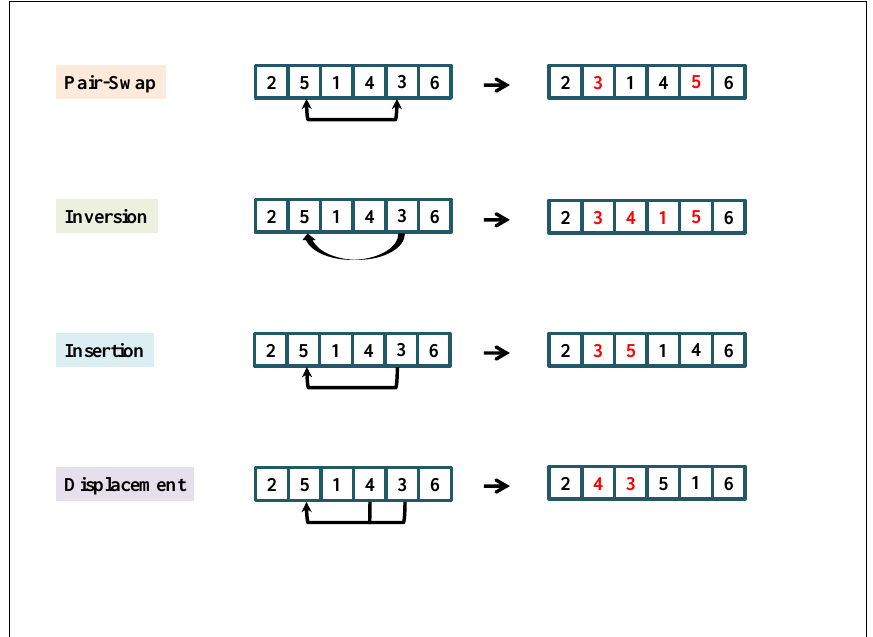
Figure 1. Examples of the different operations in the variable neighborhood search (VNS) local search